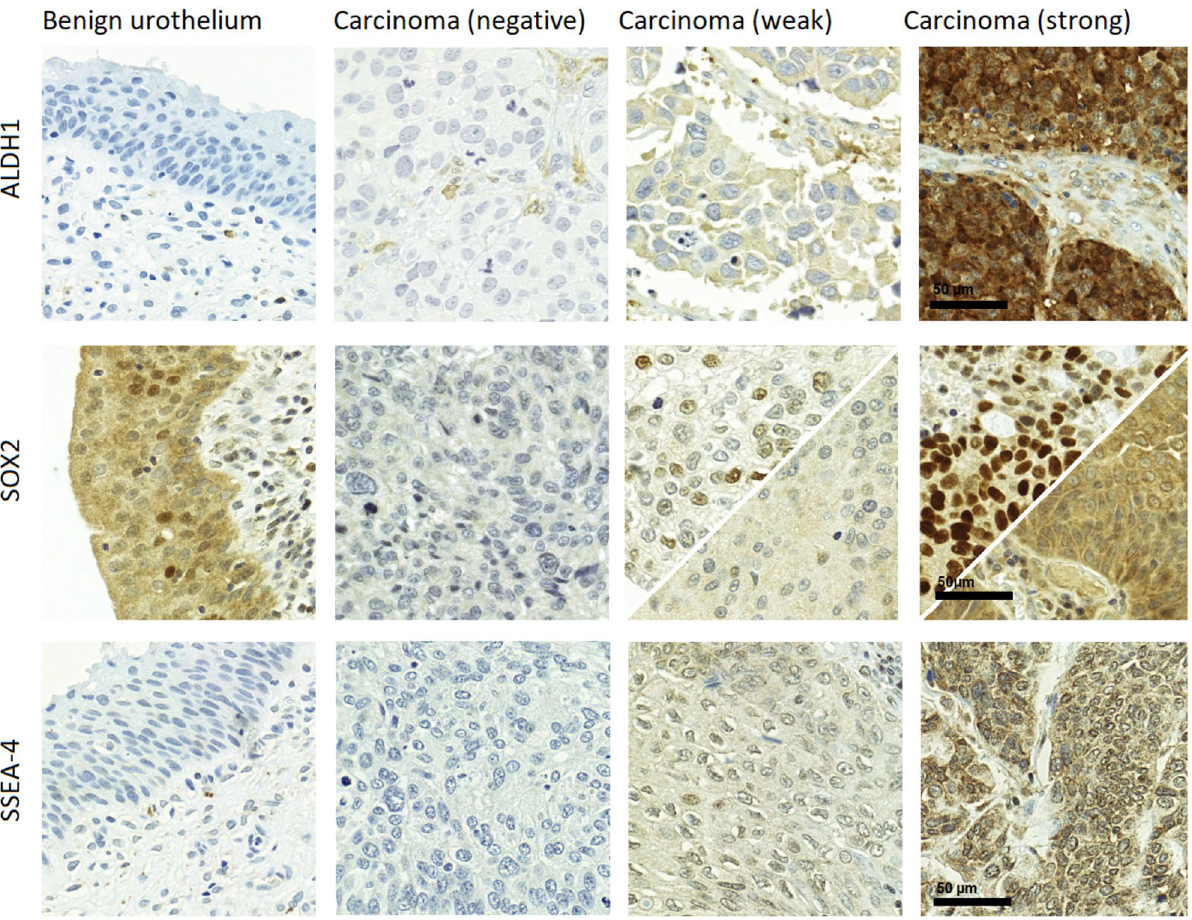
Figure 1. Representative examples of normal benign urothelium and negatively, weakly and strongly stained carcinoma tissue for ALDH1, SOX2 and SSEA-4. For SOX2, both weak/strong cytoplasmic and nuclear expression patterns are shown (nuclear staining pattern on the top half and cytoplasmic on the bottom).